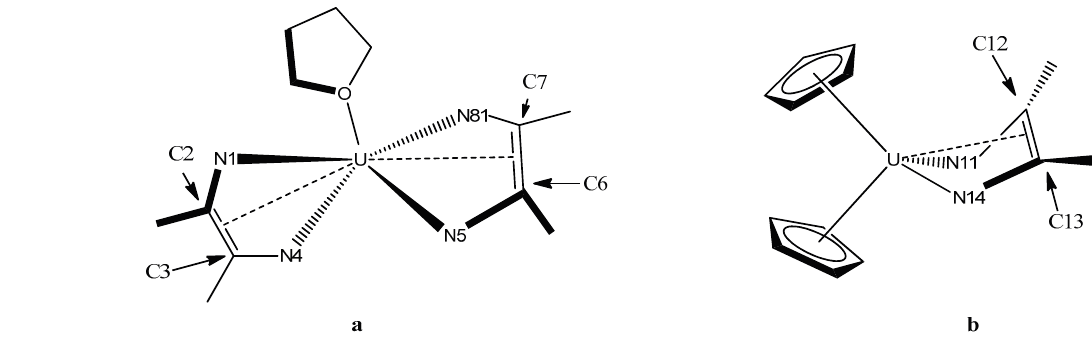
Figure 11. Molecules used for computational study. Aryl groups have been omitted for